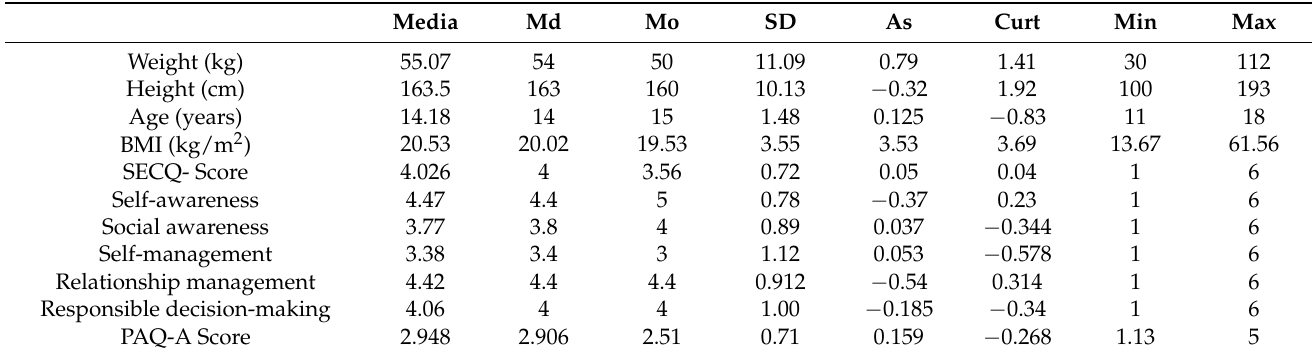
Table 2. Descriptors of the sample.